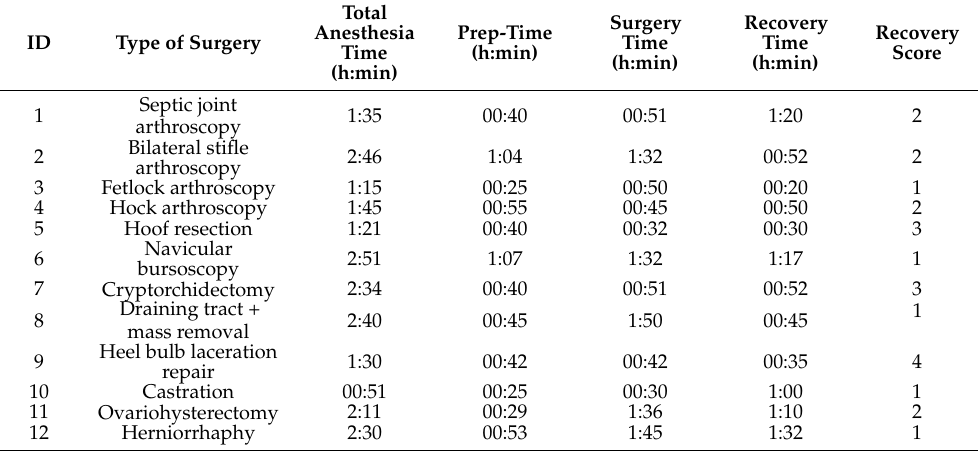
Table 2. The types of surgeries, duration of anesthesia, and the recovery score of the horses enrolled in the study. For the recovery quality scores: 4 represents the worst and 1 represents the